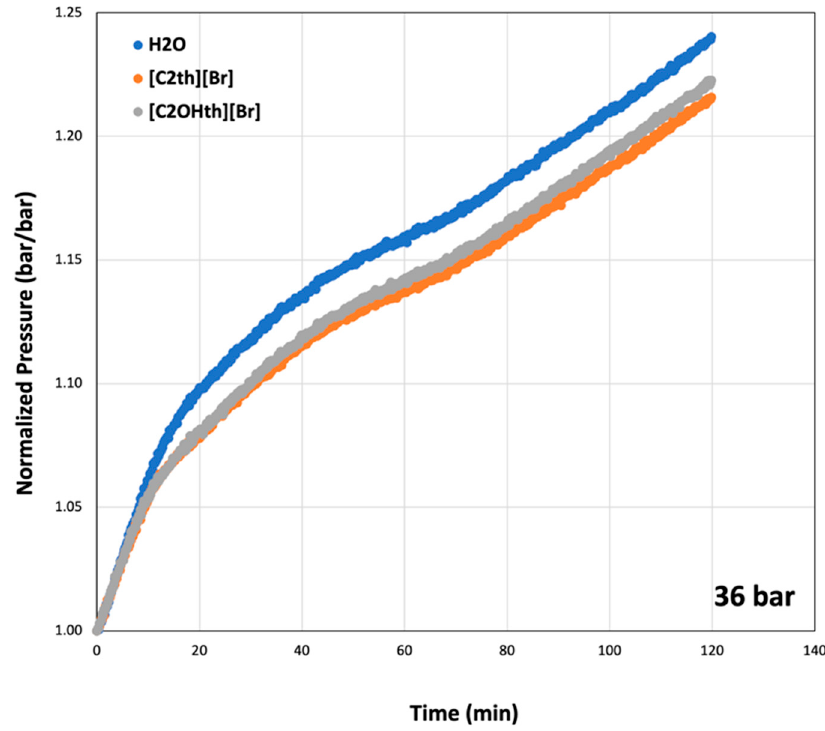
Figure 6. Normalized pressure curves at the initial pressure of 36 bar indicating decomposition of CO 2 hydrates with time in 1 wt% aqueous solutions of ionic liquids.